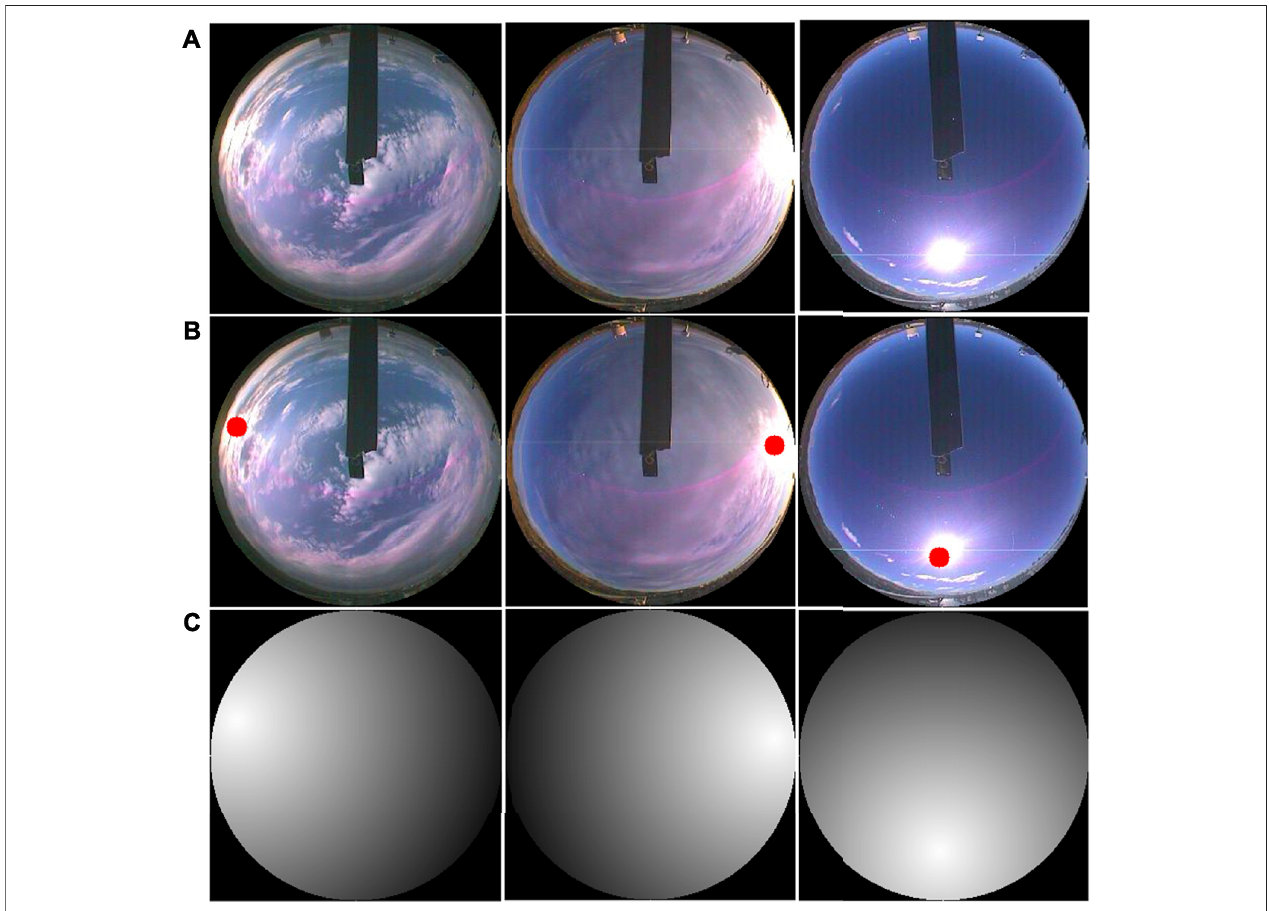
FIGURE 6 | Solar location estimation and solar mask